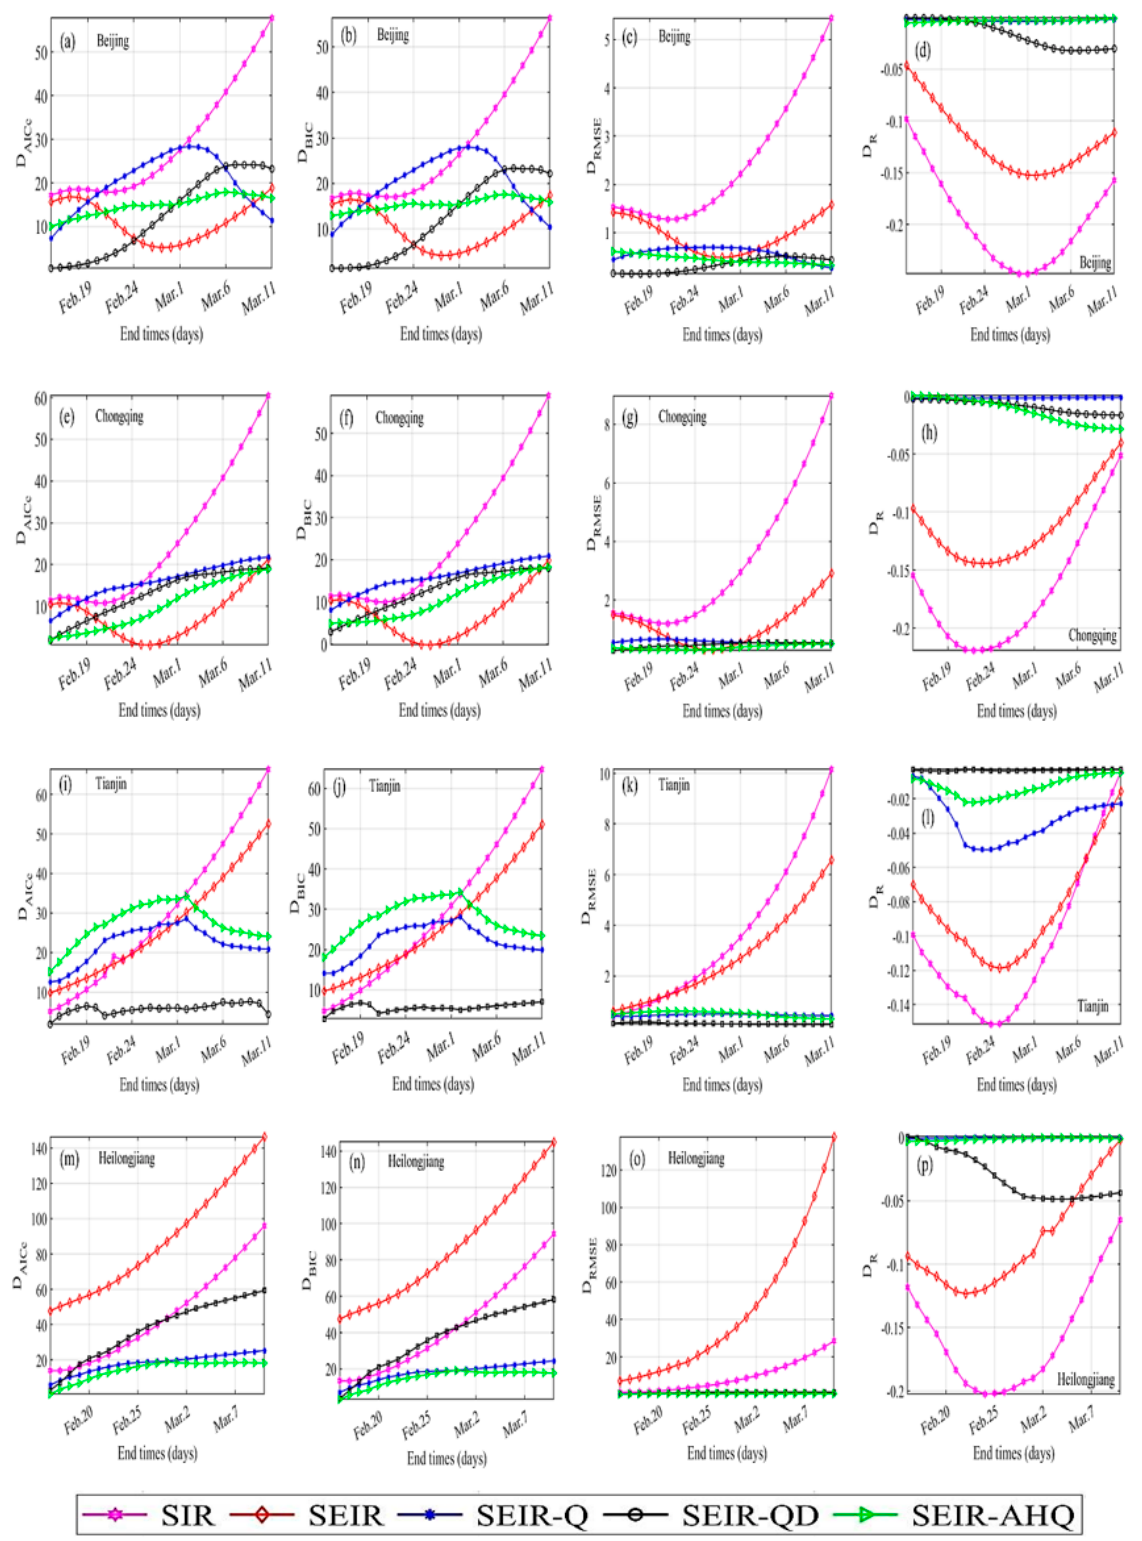
Figure 2. The difference values D j from 22 January 2020 to different end times in Beijing, Chongqing, Tianjin, and Heilongjiang. ( a – d ) D j of Beijing; ( e – h ) D j of Chongqing; ( i – l ) D j of Tianjin; ( m – p ) D j of